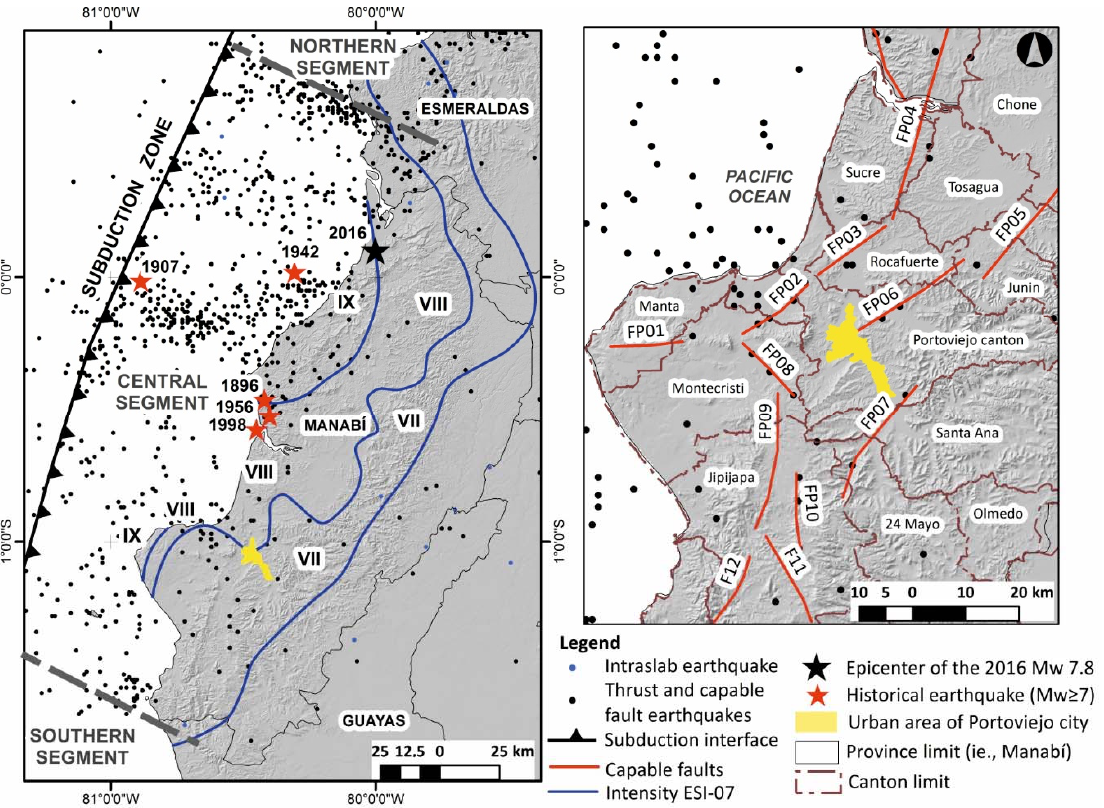
Figure 1. Illustrated seismotectonic location on the Ecuadorian coasts ( left panel ); subduction events presented in the sea of the province of Manabí ( right panel ) and upper crustal geological faults and aftershocks (16 April 2016 to 27 January 2019) [14].